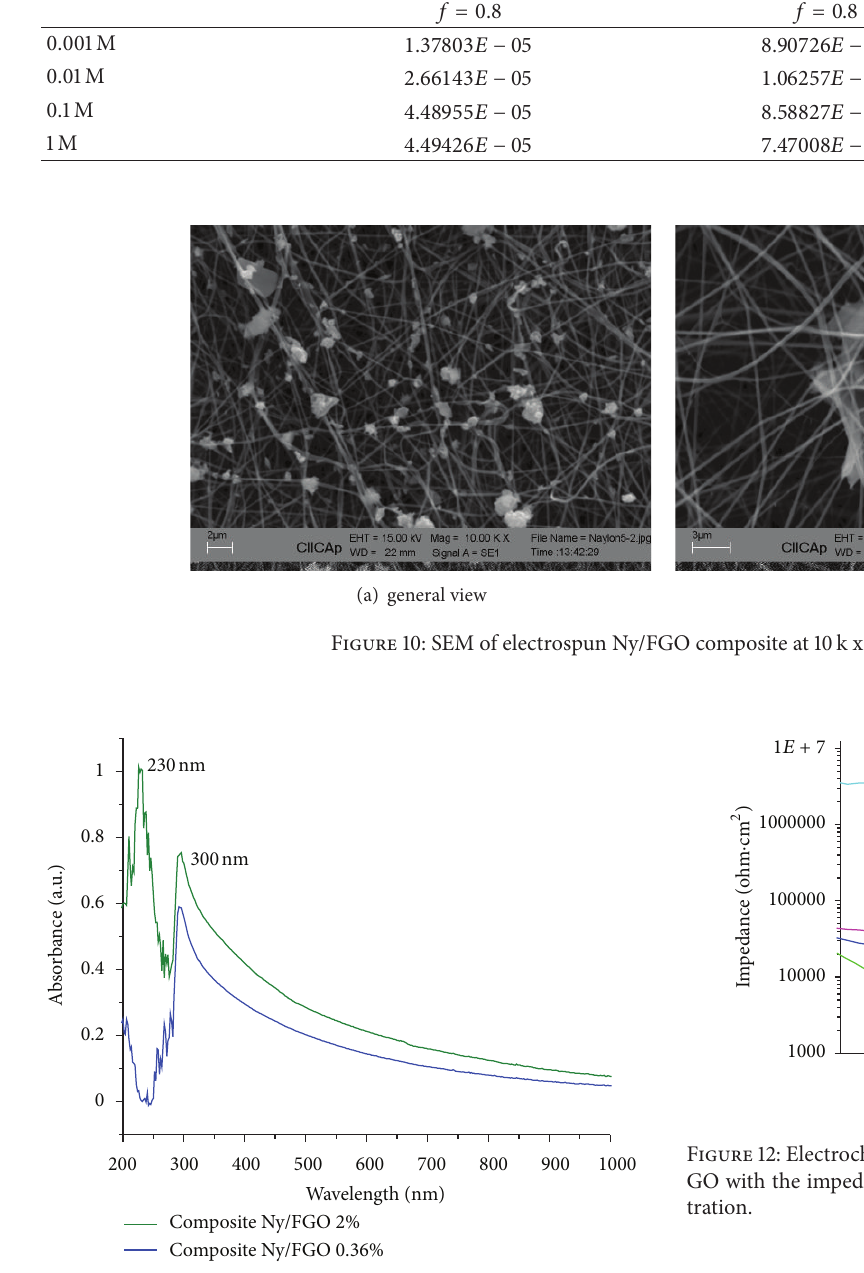
Figure 11: UV-Vis spectra of the systems: Ny/FGO with 2% and with 0.36%.